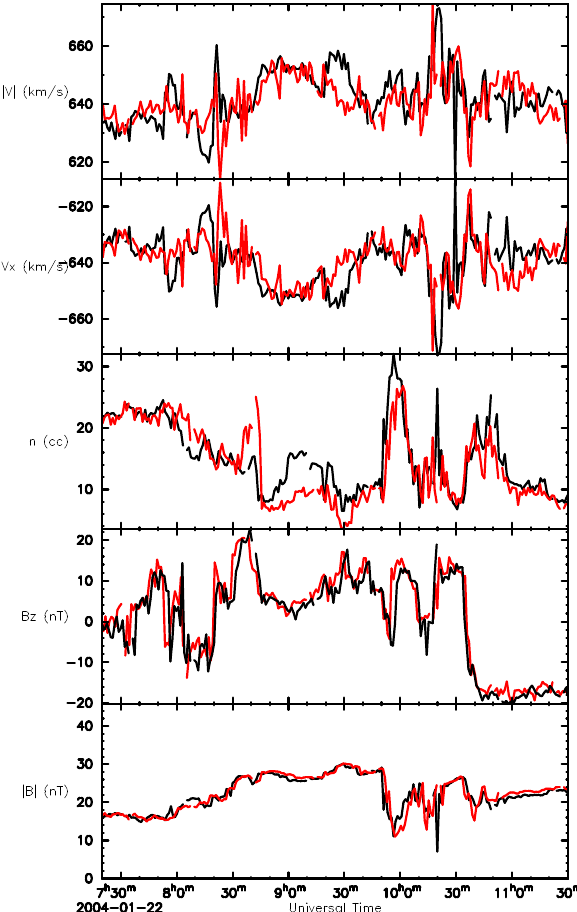
Fig. 4. Testing the lagging alogarithm: A comparison of ACE so- lar wind (red) and Cluster 1 (black), ion velocity, ion density and magnetic field data on the 10 of January 2003. The ACE data has been shifted by 58min for illustrative purposes. Cross correlation has been carried out on the B z component, measured at both space- craft (4th panel). The value of the cross correlation coefficient at intervals of 30min between 08:00 and 14:00 UT is shown in panel 5. Panel 6 shows a comparison of the lag times determined from the cross correlation analysis (crosses) and the instantaneous time lagging (dots) deduced by iterating Eq.